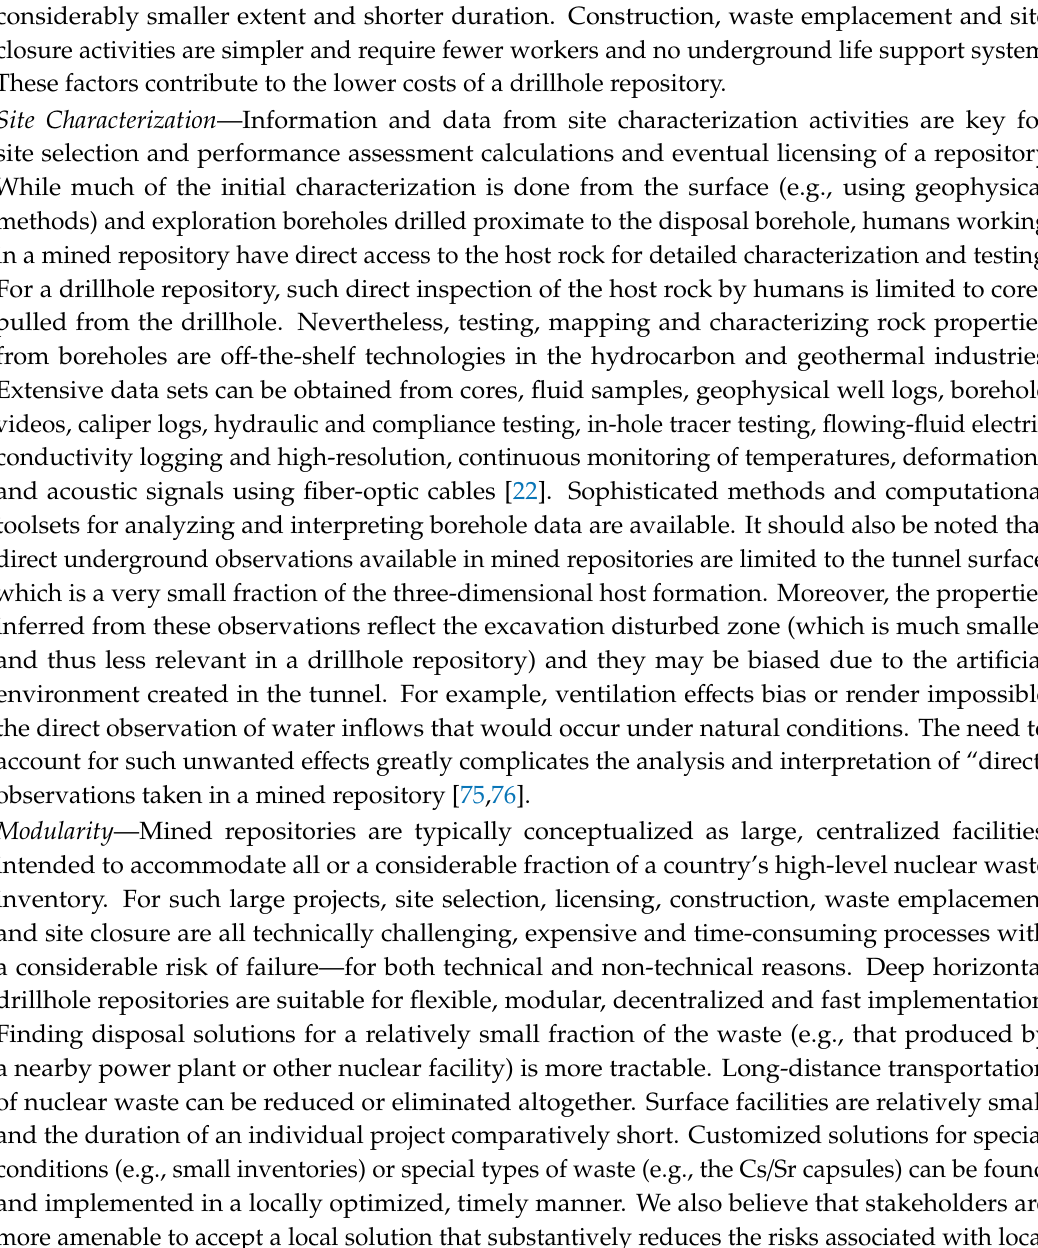
Key di ff erences between a mined repository and the deep horizontal drillhole concept are listed in Table